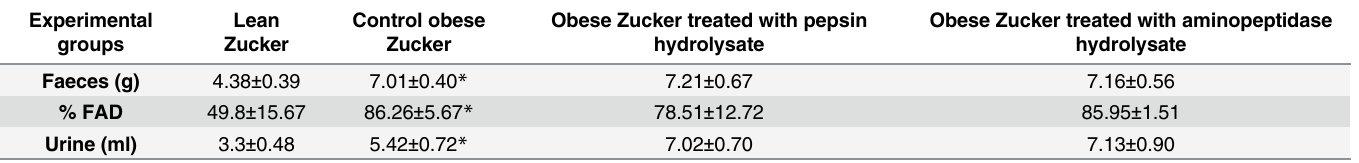
Table 1. Faeces, fat apparently digested (FAD) and urine measured during 16 h in the last week of treatment of lean Zucker rats, obese Zucker rats that received water (control) and obese Zucker rats that received 750 mg/kg/day of pepsin and aminopeptidase egg white hydrolysates for 12 weeks. Values are means ± SEM (n =